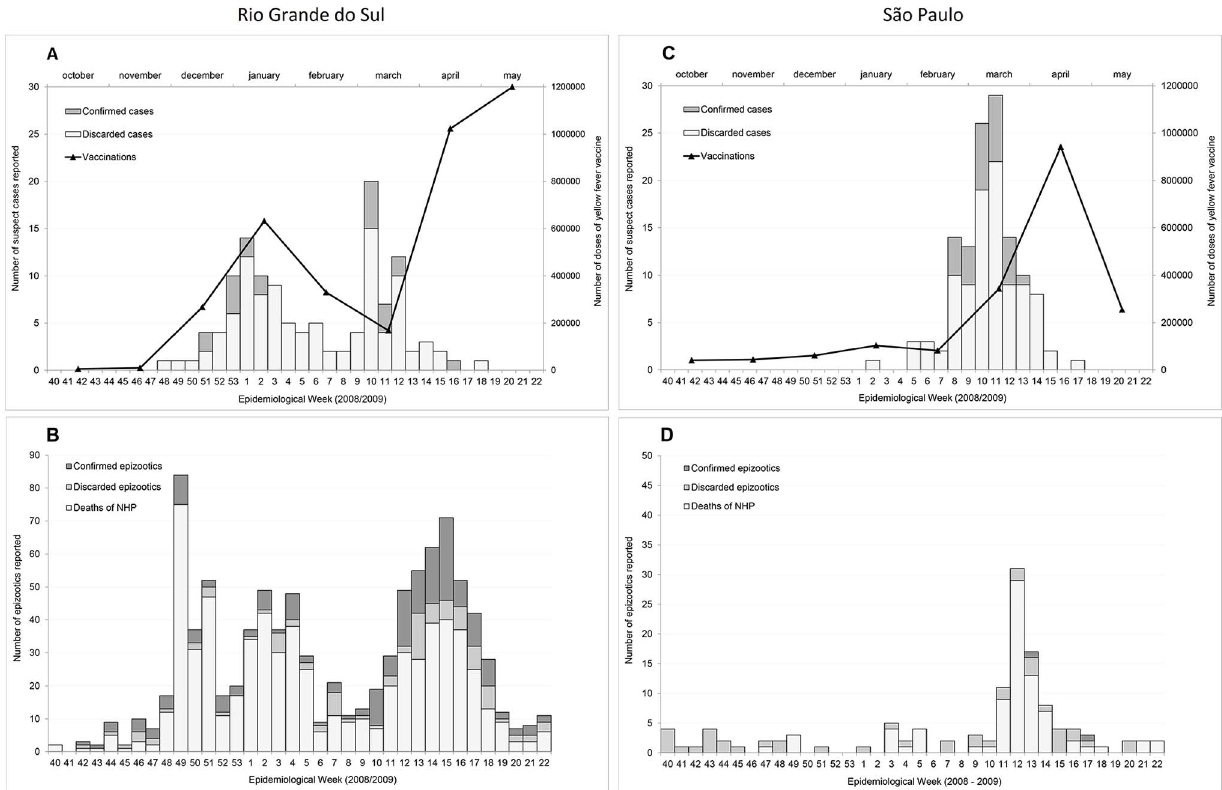
Figure 1. Notifications of suspected cases of human yellow fever and epizootics among non-human primates. Rio Grande do Sul state (Figures 1a and 1b) and Sa˜o Paulo state (Figures 1c and 1d). Data from the national yellow fever surveillance system according to week of occurrence, October 2008–June 2009, and final classification of cases and epizootics: confirmed, discarded (laboratory negative) and unconfirmed (classified as death of non-human primate when no specimens were available for testing).